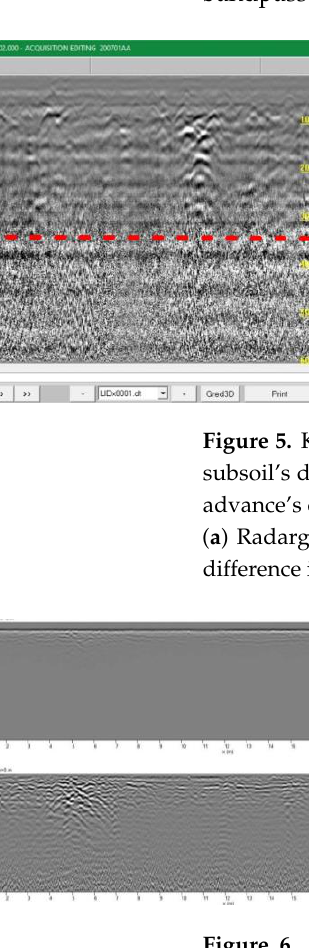
Figure 6. Comparison among radargrams before and after signal processing. ( a )-( a’ ) 200 MHz; ( b )-( b’ ) 600